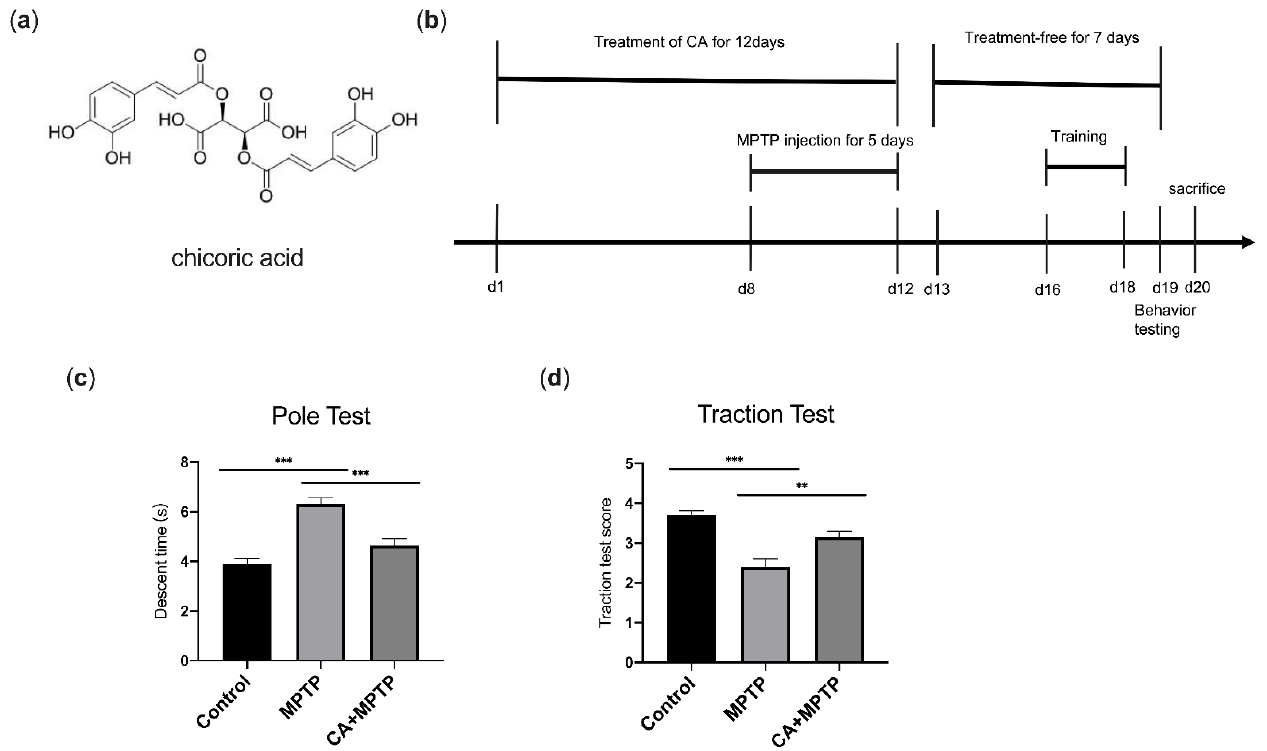
Figure 1. CA improved behavioral deficits in PD mice. ( a ) Chemical structure of CA. ( b ) Timeline for the experimental procedure. ( c ) Pole test: time to descend the pole. ( d ) Traction test: score of traction reflexes. Statistical comparison by one-way ANOVA with Tukey’s post hoc test. Data represent means ± SEM. ** p < 0.01, *** p < 0.001. n = 10.